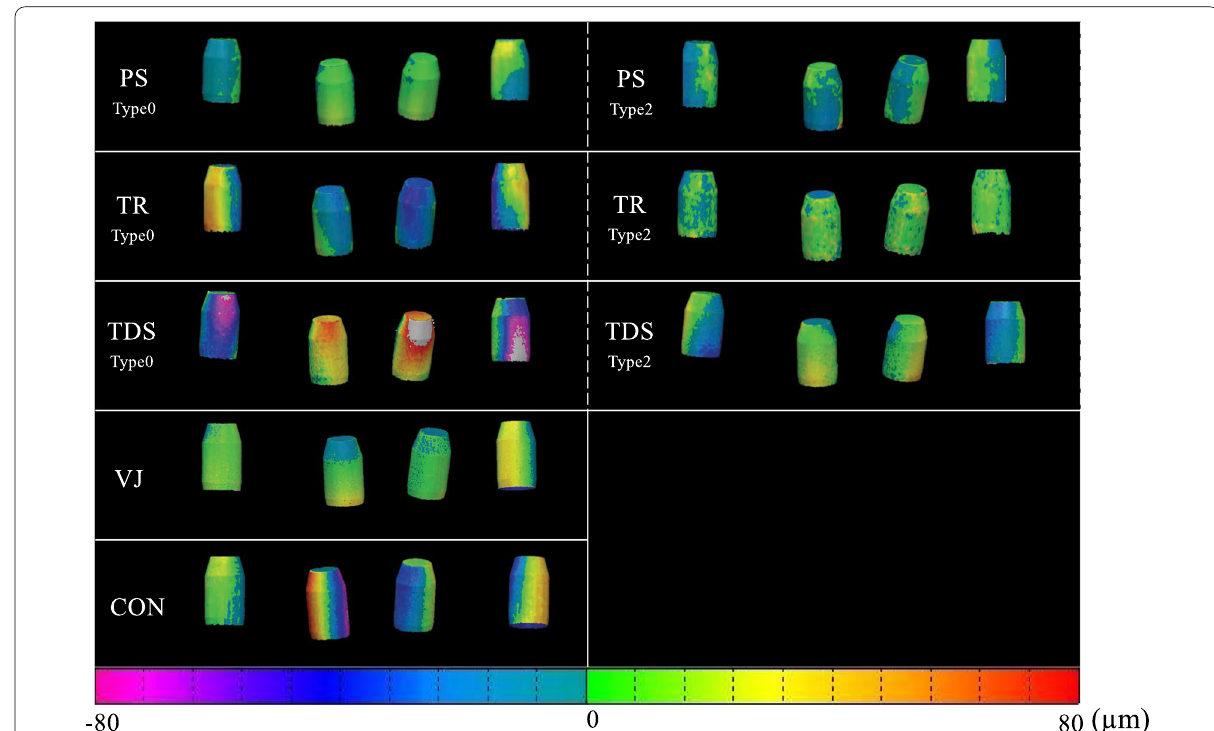
Fig. 4 Color-coded deviation maps of surface deviation. They were produced by superimposing two STL datasets through the best-fit algorithm in each IOS for Type 0, 2, and VJ, CON. CON conventional impression, IOS intra-oral scanners, VJ verification jig